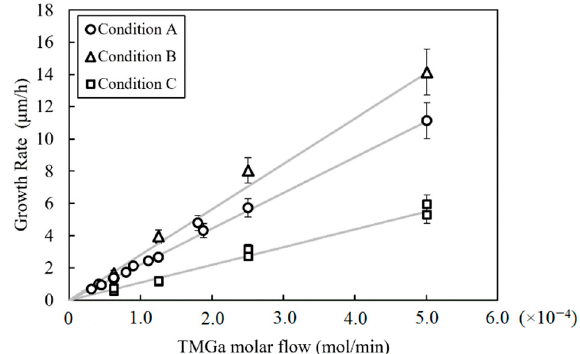
Figure 2. GaN growth rate vs. TMGa molar flow data (points) and curve fits (lines) for OMVPE conditions A, B, and C. Error bars are set to ±10%.